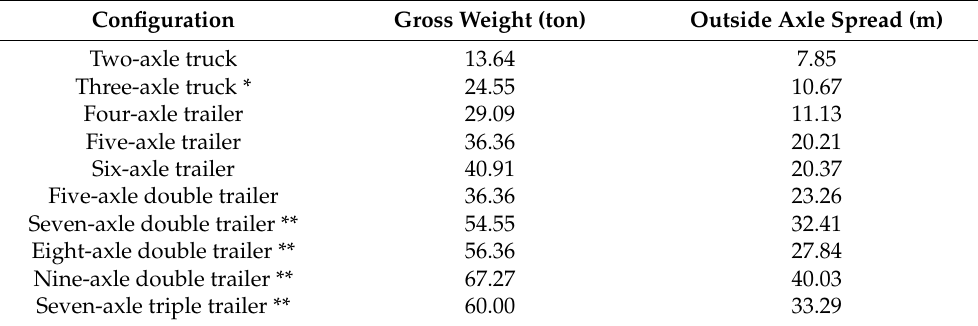
Table 2. Standard trucks for bridge impact testing. The three-axle truck (*) may have variable outside axle spread up to 13.4 m (44 (cid:48) ) with the same tractor configuration as the two-axle truck. Longer combination vehicles (**) are not allowed in Japan road